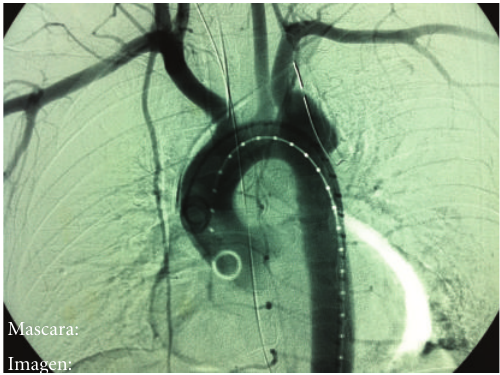
Figure 1: Arteriography where it is observed the pseudoaneurysm of the left subclavian artery.